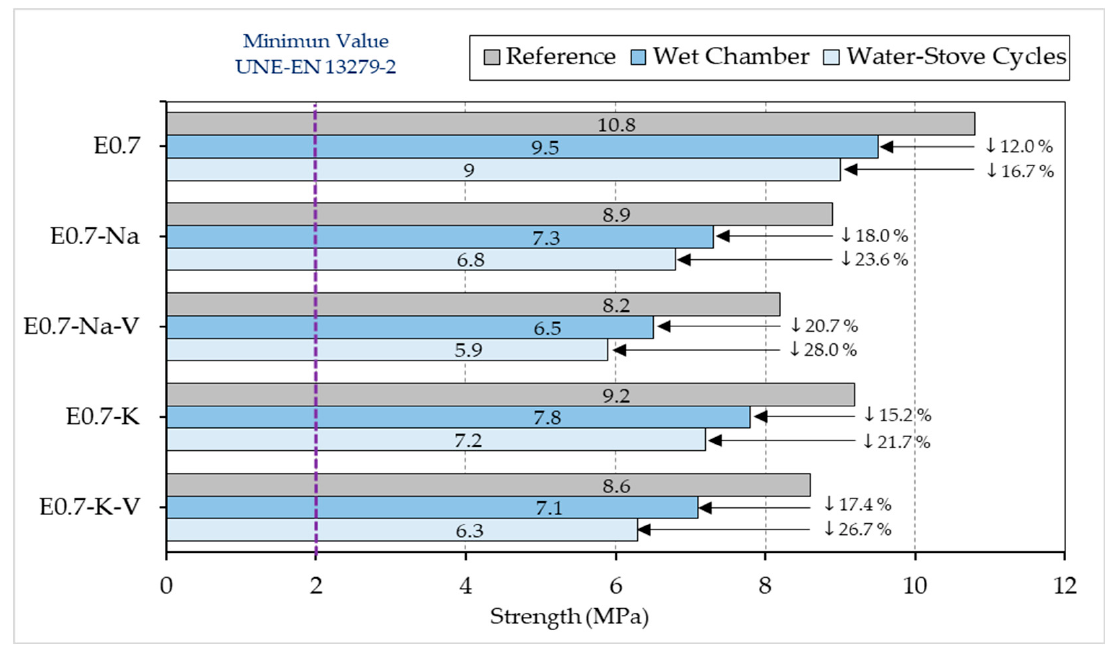
Figure 7. Compressive strength results compared (MPa).